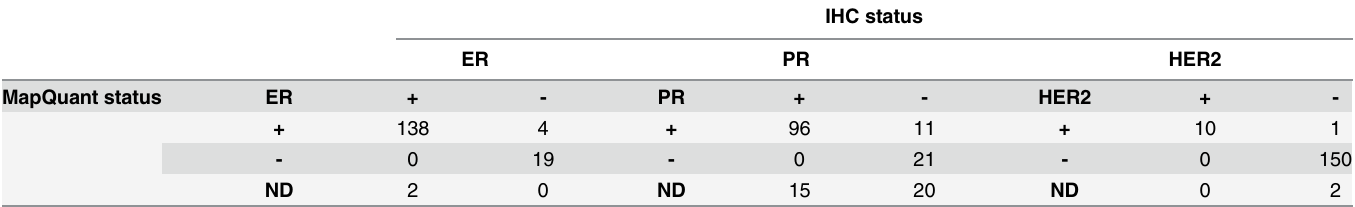
Table 2. MapQuant test values of Estrogen-Receptor (ER), Progesterone-Receptor (PR) and HER2 status compared to immunohistochemistry (IHC).